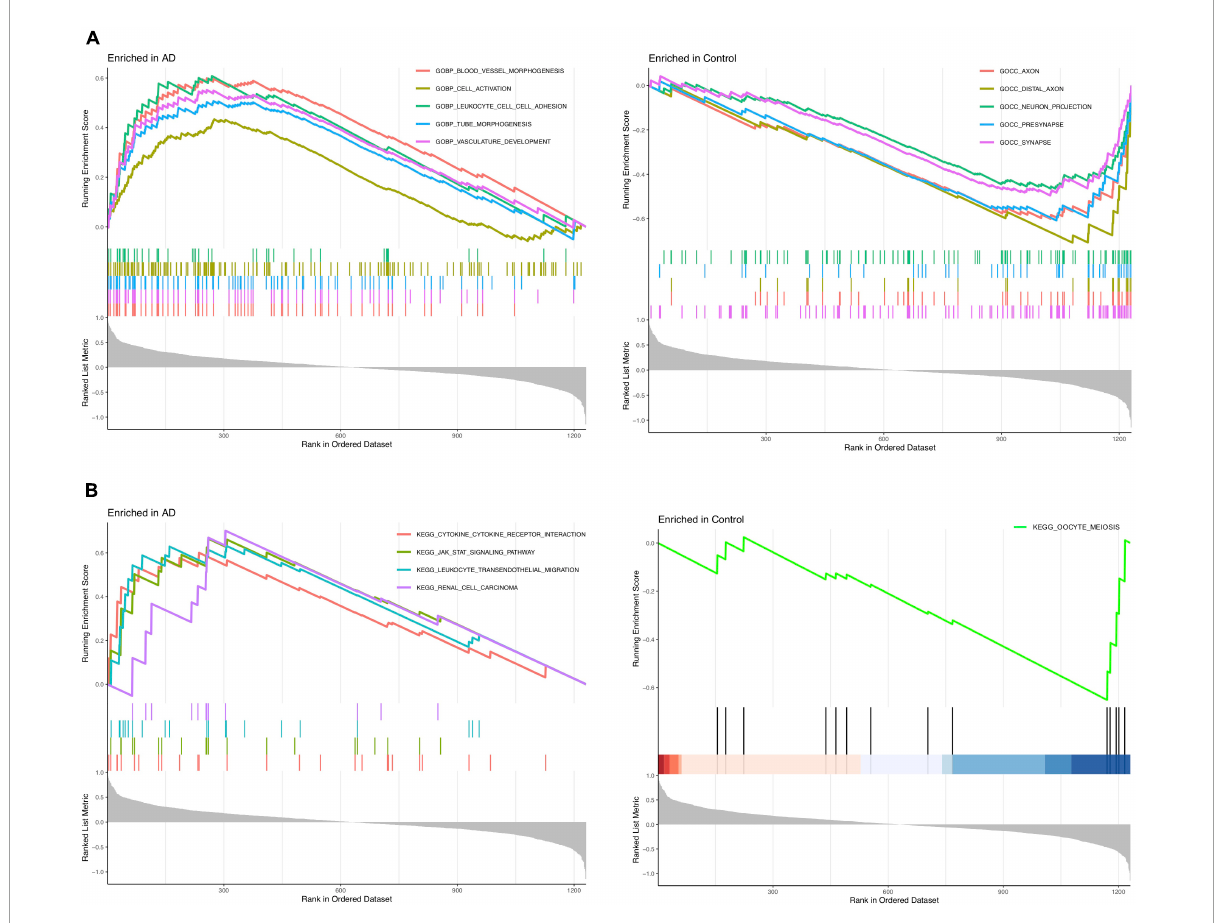
FIGURE3 Enrichment analysis to investigate the potential function of differentially expressed genes (DEGs). (A) GSEA_GO analysis in Alzheimer’s disease (AD) or control group. (B) GSEA_KEGG analysis in AD or control